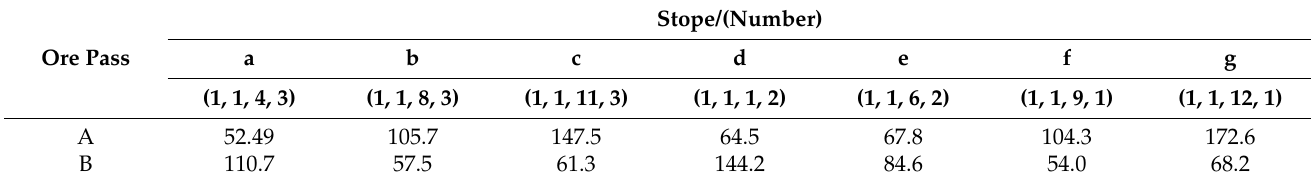
Table 3. Empty travel time of the scraper between the stope and ore pass in ( 1, 1 ) sublevel/s (Units: s).